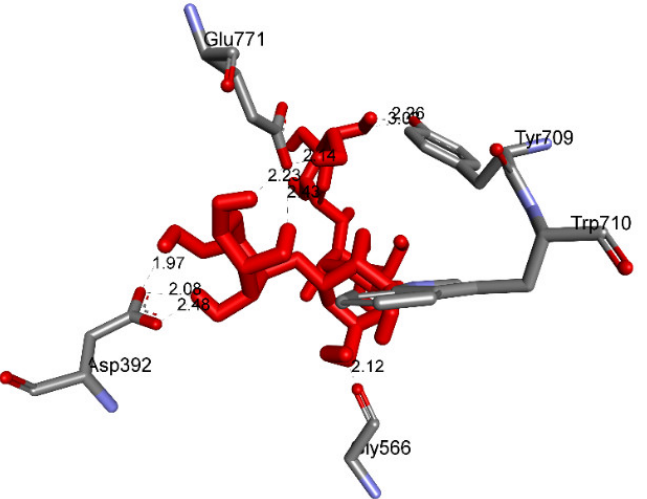
Figure 11. The hydrogen bonds and electrostatic interactions bound from active atoms on the ligand acarbose, a standard drug, to active atoms on residual amino acids on enzyme 4J5T.